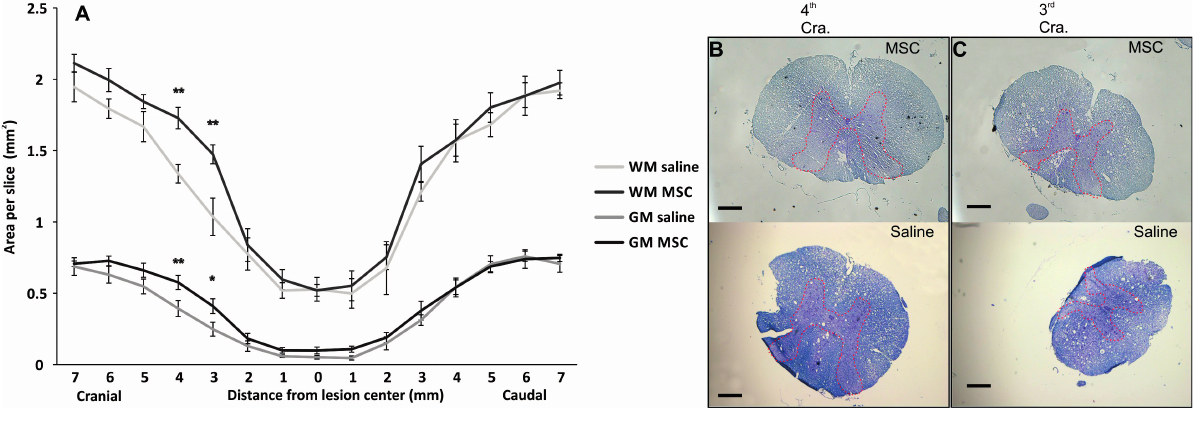
Figure 3. Morphometry measurement of the spinal cord lesion of spared white and gray matter in the lesion center. ( A ) MSC-transplanted rats showed significantly preserved gray matter in the whole area of interest and spatially preserved white matter; Local significance was detected particularly in the cranial direction from the central lesion part at 4-mm ( B ) and 3-mm slices ( C ). The red dotted line depicts the border of grey matter. Statistical significance was marked with * , where p < 0.05, or with ** , where p < 0.01. Scale bar: ( B , C ) 0.4